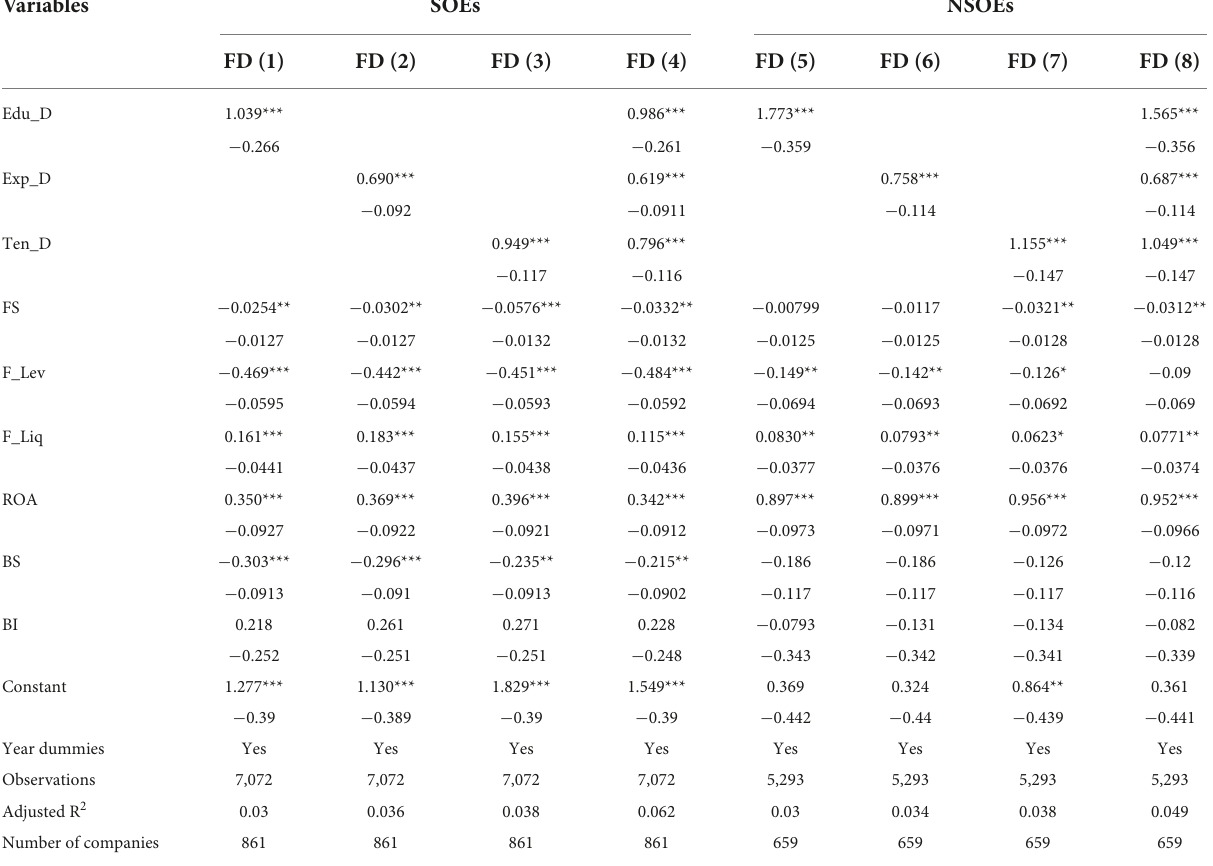
TABLE 6 Fixed effect regression results for SOEs and